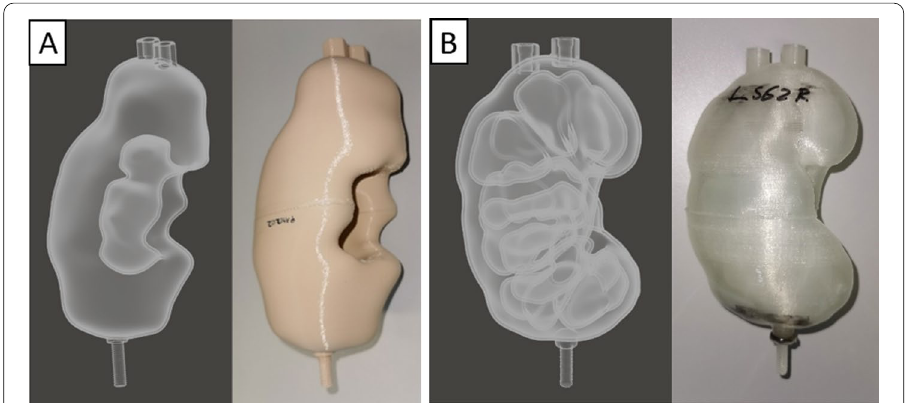
Fig. 1 Computer-aided-design models and printed phantoms. Computer-aided-design (CAD) models (left side) and printed phantoms (right side) for whole-parenchyma ( A ) and cortex-only phantoms ( B )